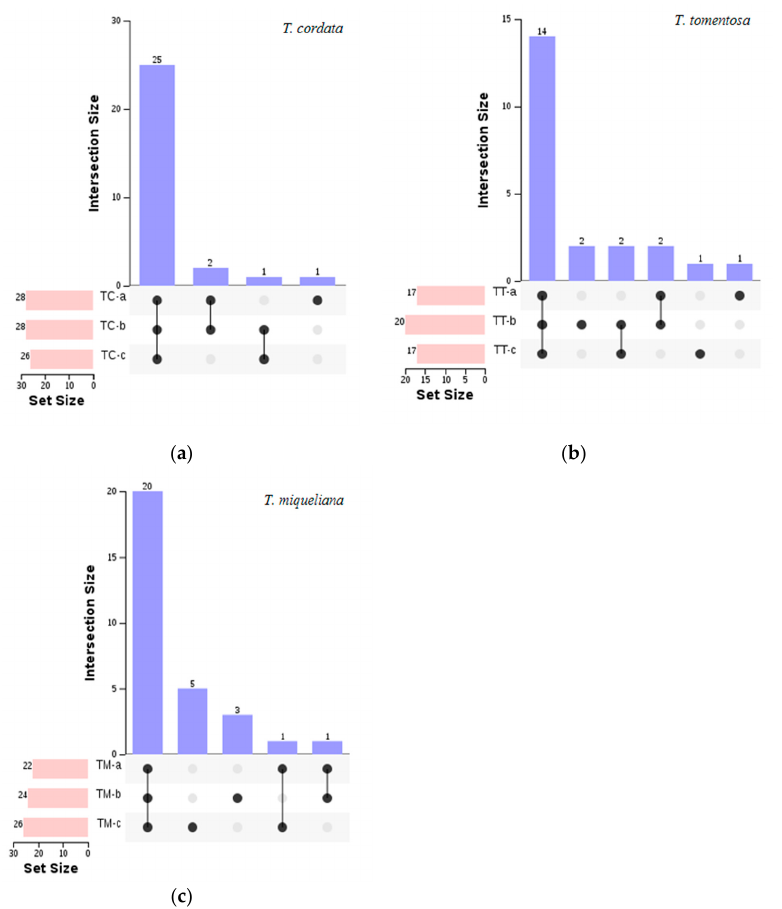
Figure 2. UpSet diagrams based on the aroma components at different flowering stages of the three species. (a) T. cordata ; (b) T. tomentosa ; (c) T. miqueliana. Note: "set size" represents the dataset of aroma components in each species of Tilia at different flowering periods; the horizontal bar chart on the left represents the statistical value of floral fragrance components in each period; the single point of the intermediate matrix represents the existence of unique aroma components in a certain period, and 2 or 3 points are connected by lines to represent the unique components with intersection of multiple periods; the numbers at the top of the vertical bars represent the values of the unique aroma components at the intersection points at different periods.